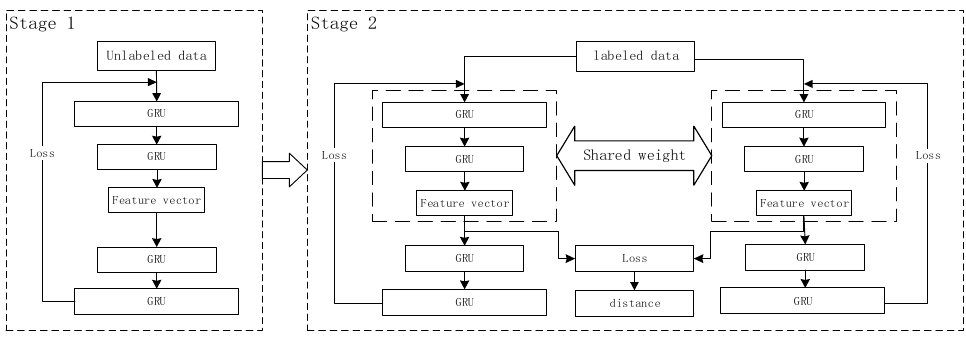
Figure 3. The overall flow of the algorithm.